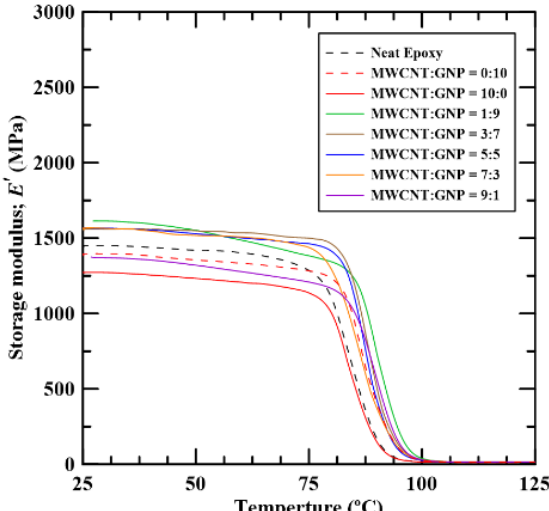
Figure 5. Temperature dependence of the storage modulus E ′ of the epoxy composites with various MWCNT:GNP ratios.